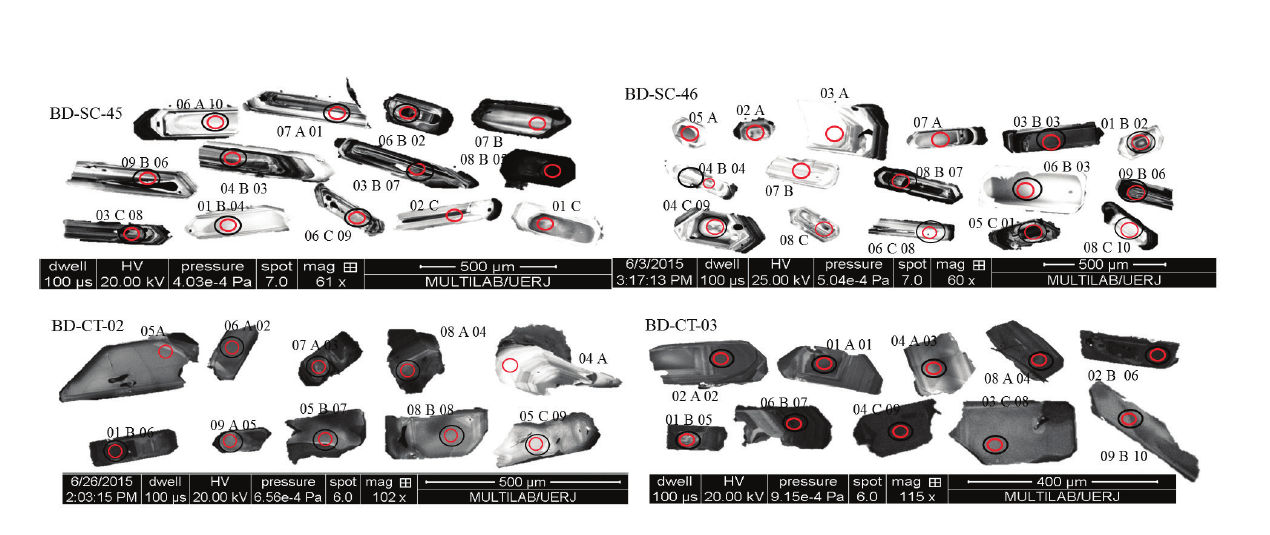
FIGURE 4 – Zircon grains from the Massangana, São Carlos and Caritianas massifs analyzed by LA-ICP-MS. The red circles correspond to the U-Pb analysis and the black ones to Lu-Hf. Note that both U-Pb and Lu-Hf analysis were shot in the same part of the zircon, what guarantees greater coherence in results and